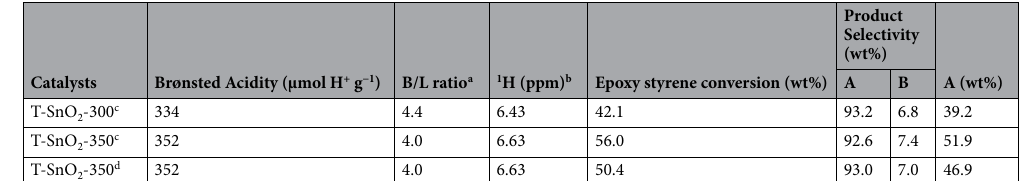
Table 3. Comparison of catalytic activity of T-SnO 2 -300 and T-SnO 2 -350 catalysts for alcoholysis of epoxy styrene with methanol under identical amount of Brønsted acidic sites. a Reaction conditions: epoxy styrene = 2 g, methanol = 5.3 g (mole ratio = 1:10), reaction temp = 65 °C, time = 30 min. a Py-FTIR, b1 H MAS NMR, c catalyst = 0.1 g, d identical number of Brønsted acidic sites (33 μmol H + g −1 ) as in T-SnO 2-phenylethanol, B = phenyl